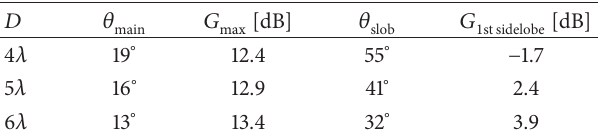
Figure 8: Radiation patterns with different OAM states in E-plane. of the maximum gain 𝐺 max and Table 1: Variation of the angle 𝜃 main of the 1st side lobe with the array diameter 𝐷 for mode angle 𝜃 slob ℓ = +3 .